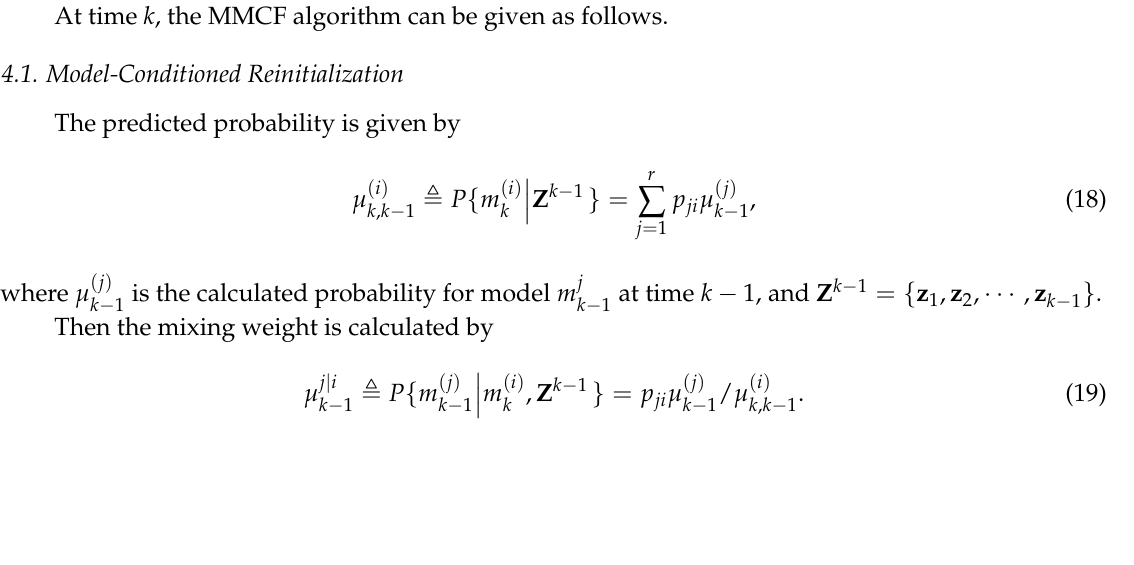
Figure 3. Structure of multi-model combined filtering with dual uncertainties (MMCF) algorithm (with three models).